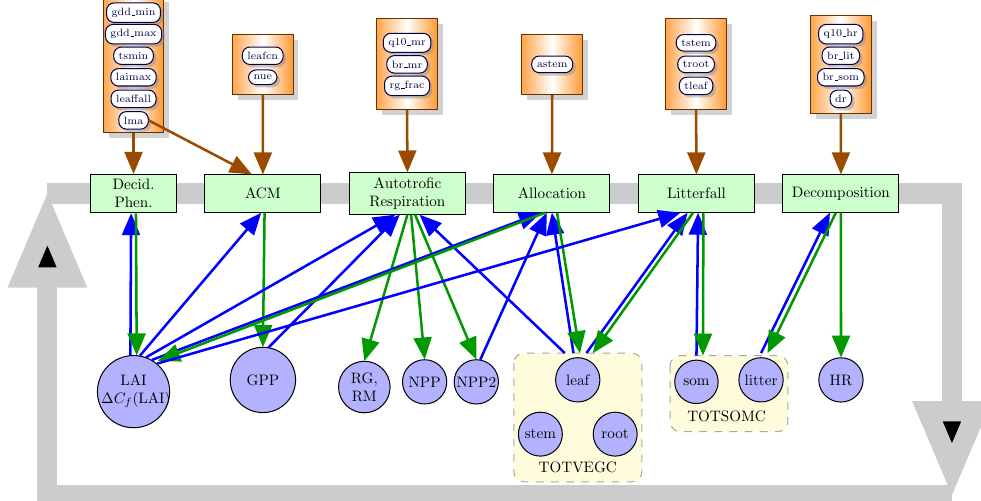
Figure 2. Schematic of processes, shown with green boxes, in DALEC with associated parameters, listed in orange boxes. The blue arrows indicate how internal parameters and QoIs, shown with blue circles, impact DALEC processes, while the green arrows show the impact of processes on the QoI and other internal